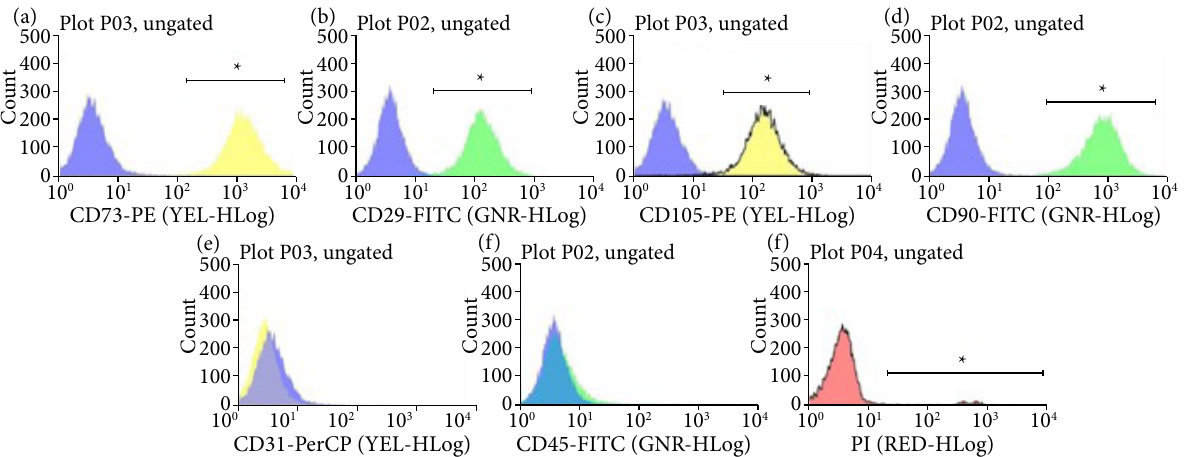
Figure 8 - Immunophenotyping of fibroblasts. Results of fibroblast’s immunophenotyping are represented in histogram, with 10,000 events per graph. Cells labeled with antibody anti-human (control) conjugated with fluorophorephycoerythrin (PE) ( a, c, and e ) or fluorescein isothiocyanate (FITC) ( b, d, and f ) have their population represented at left in the graph. Positive labels for fibroblast: (a) anti-CD73 conjugated with PE; (b) anti-CD29 conjugated with FITC; (c) anti-CD105 conjugated with PE; (d) anti-CD90 conjugated with FITC. Negative labels for fibroblast, but positive for endothelial cells: (e) CD-31 conjugated with peridinin chlorophyll protein complex (PerCP) and for hematopoietic cells in (f) anti-CD45 conjugated with FITC. (g) Cells labeled with propidium iodide, marker of dead cells. The left population represents live cells, and the right population represents dead cells